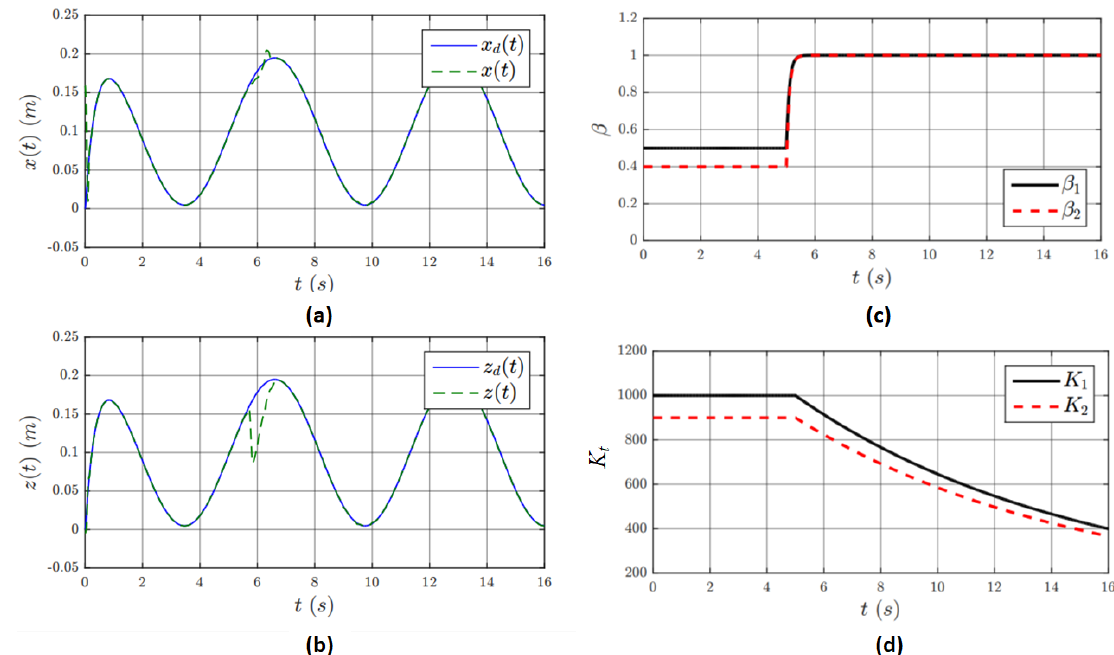
Figure 7. The Cartesian positions x (a) and z (b) for the sinusoidal trajectory case. (c) The evolution of β for the sinusoidal trajectory case. (d) The evolution of K t for the sinusoidal trajectory case.